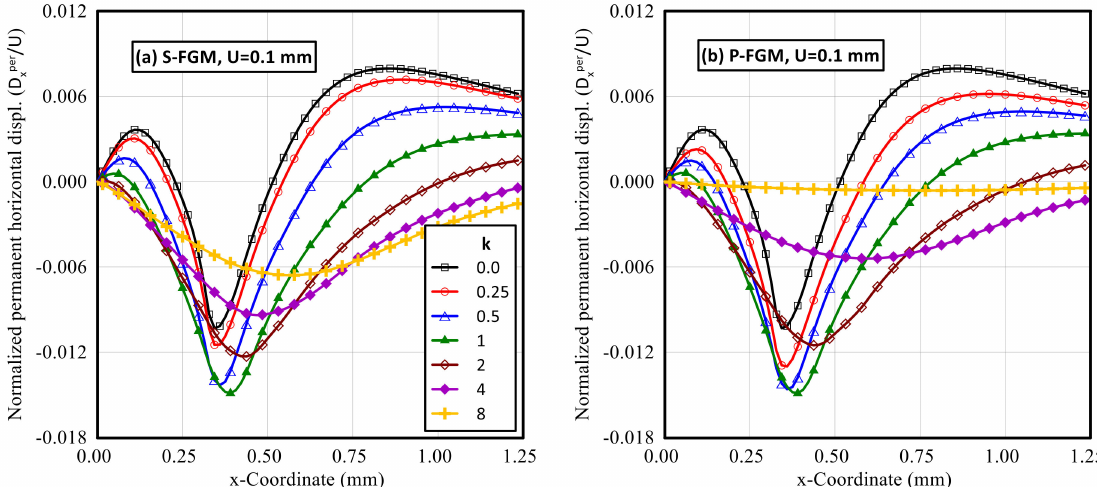
Figure 14. Profiles of the permanent horizontal displacement (after unloading) along the upper surface of an elastoplastic Ti/TiB specimen at different gradient indices; ( a ) S-FGM, and ( b ) P-FGM.